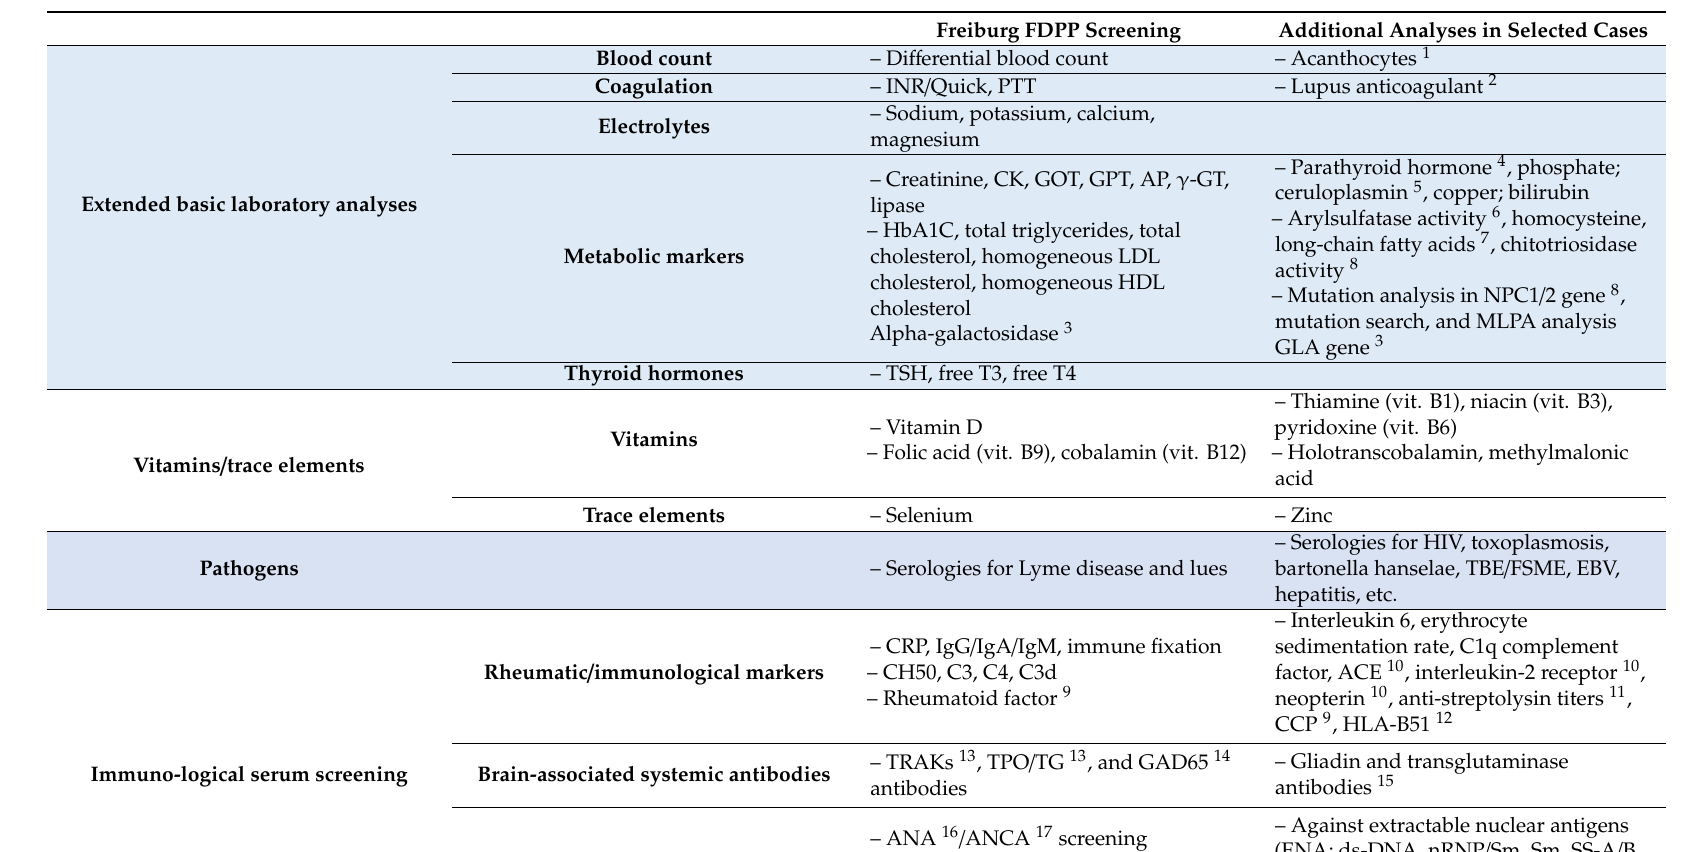
Table 1. Screening approach in patients with schizophrenia spectrum